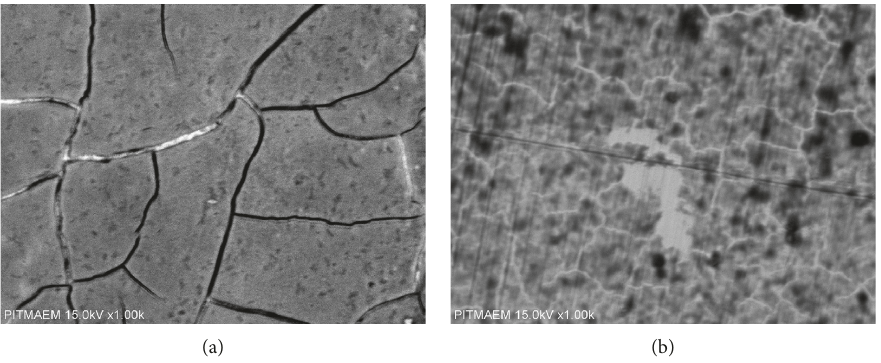
Figure 14: SEM images of acid orange-treated PR